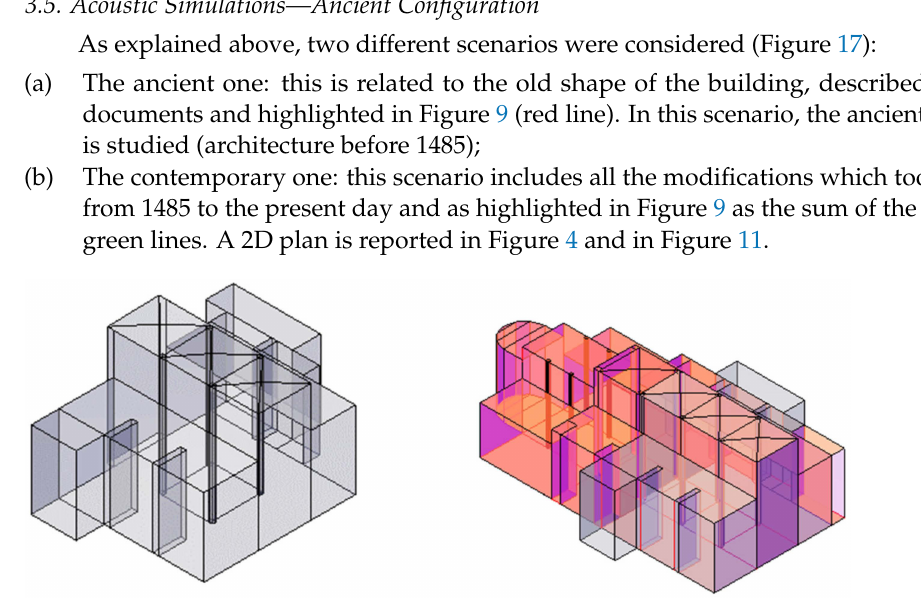
Figure 17. Virtual models of the two different scenarios: ancient ( left ) and contemporary ( right